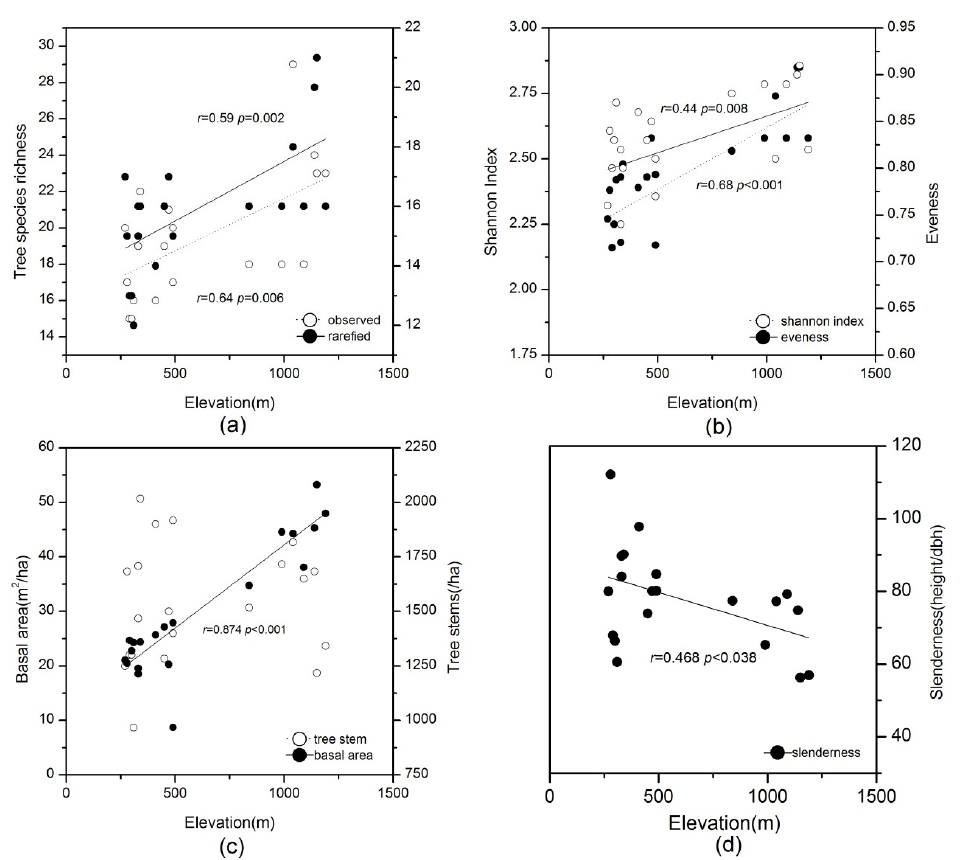
Figure 2. Tree diversity and structural parameters as a function of altitude. Correlations are significant ( p < 0.05): ( a ) observed and rarefied ( N = 59) richness; ( b ) Shannon diversity index and evenness; ( c ) basal area (m 2 /ha) and tree density; ( d ) stem slenderness (ratio of height to dbh).